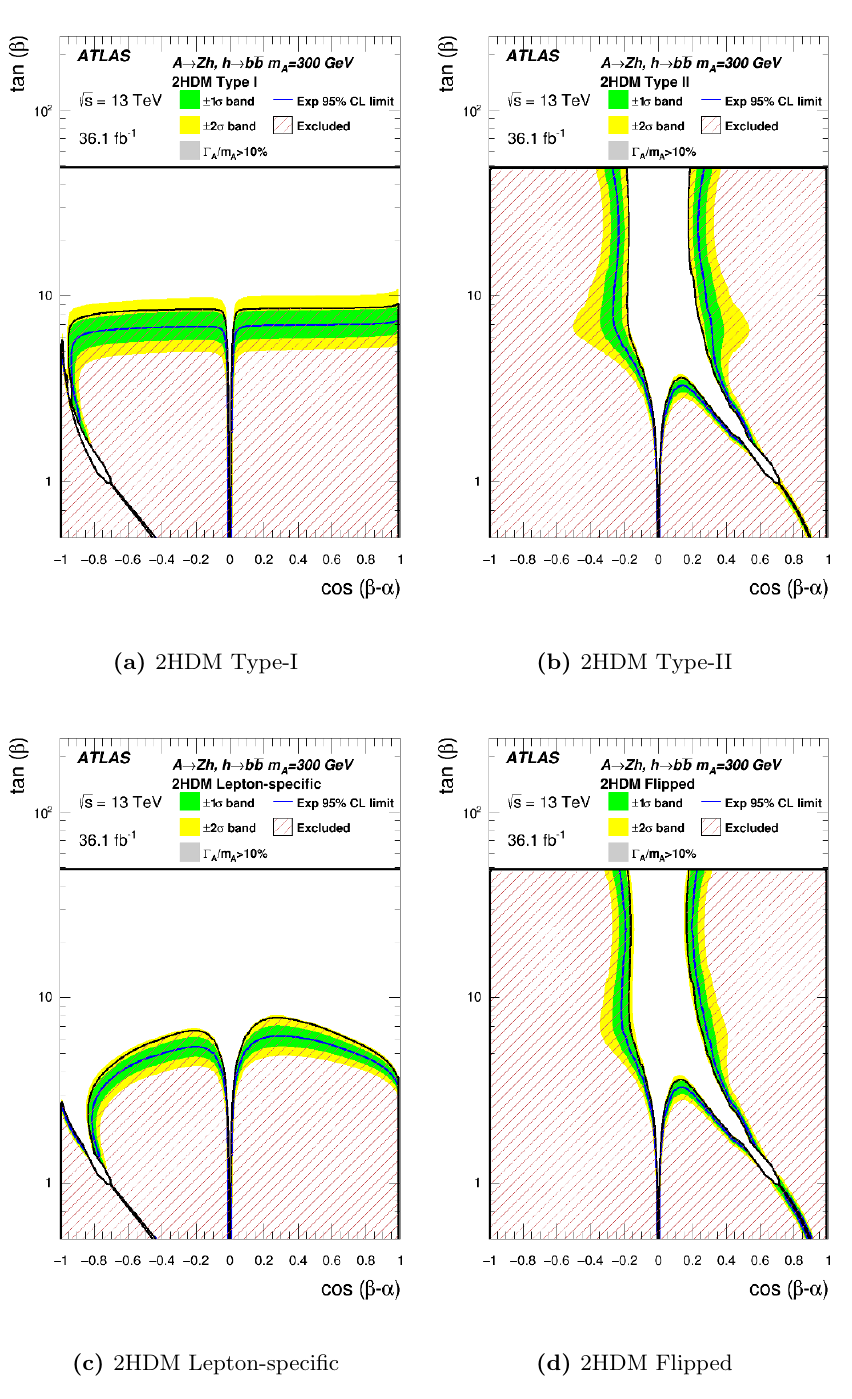
Figure 7. The interpretation of the cross-section limits in the context of the various 2HDM types as a function of the parameters tan( (cid:12) ) and cos( (cid:12) (cid:0) (cid:11) ) for m A = 300 GeV: (a) Type-I , (b) Type-II, (c) Lepton-speci(cid:12)c, and (d) Flipped. Variations of the natural width up to (cid:0) A =m A = 10% have been taken into account. For the interpretation in Type-II and Flipped 2HDM, the b -quark associated production is included in addition to the gluon-gluon fusion production.